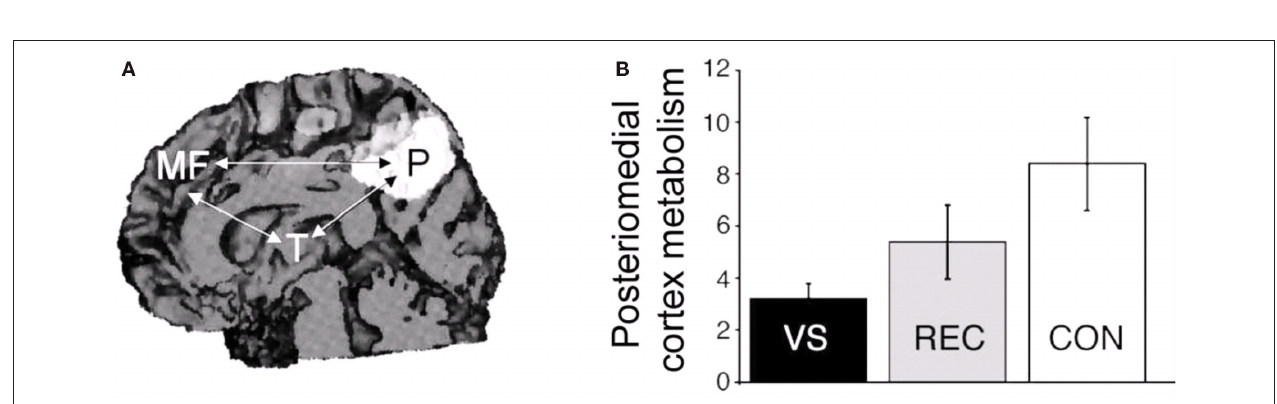
Figure 4 | The most representative nodes of the “default mode network” show a decrease in functional connectivity as we move from normal consciousness and locked-in syndrome (red squares) to minimally conscious or unconscious states. Graphs represent connectivity strength (mean z scores with 90% confidence intervals). PCC, posterior cingulate cortex. Adapted from Vanhaudenhuyse et al. (2009).